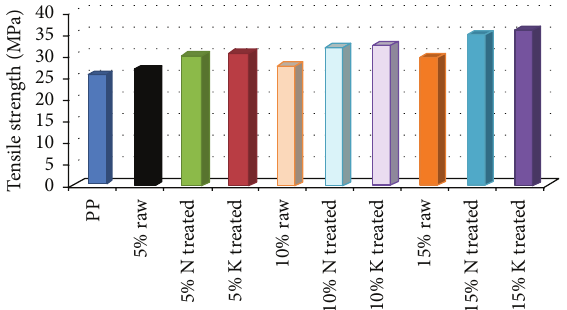
Figure 4: The ultimate tensile strength (UTS) of different percent- ages of raw and treated BBF/PP composites.